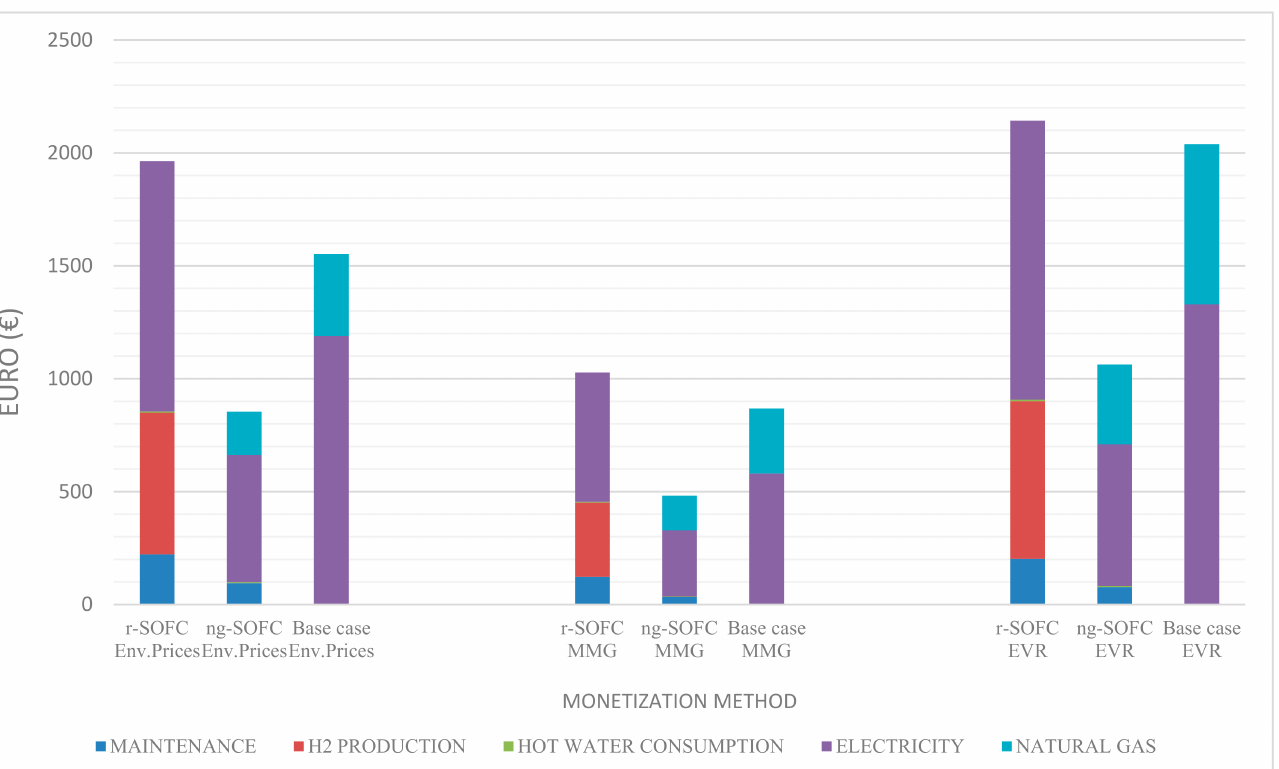
Figure 7. Total environmental costs for each